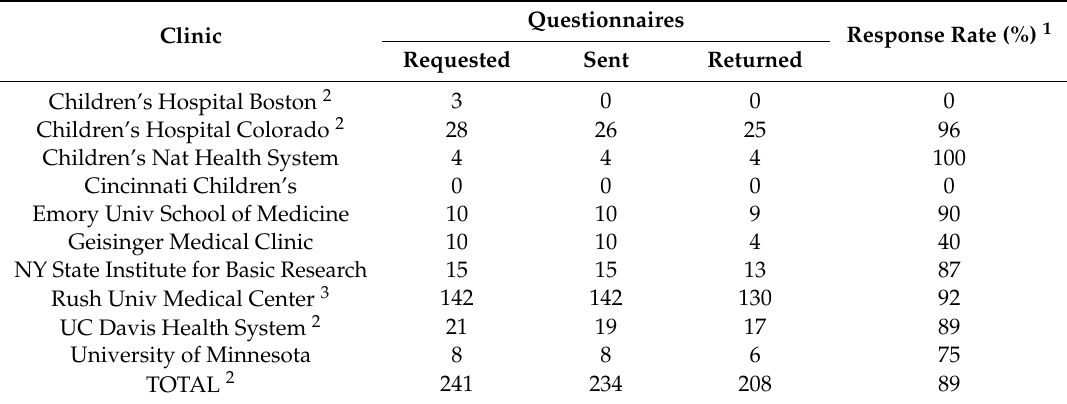
Table 2. Subject Participation Phase 2.